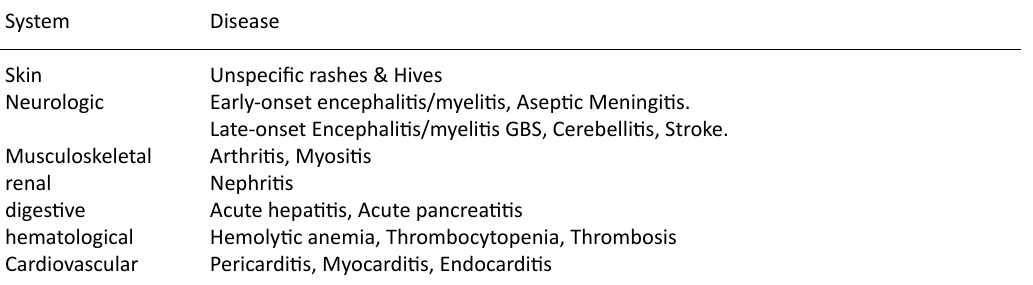
table 1. M. pneumoniae extrapulmonary diseases reported in children 78